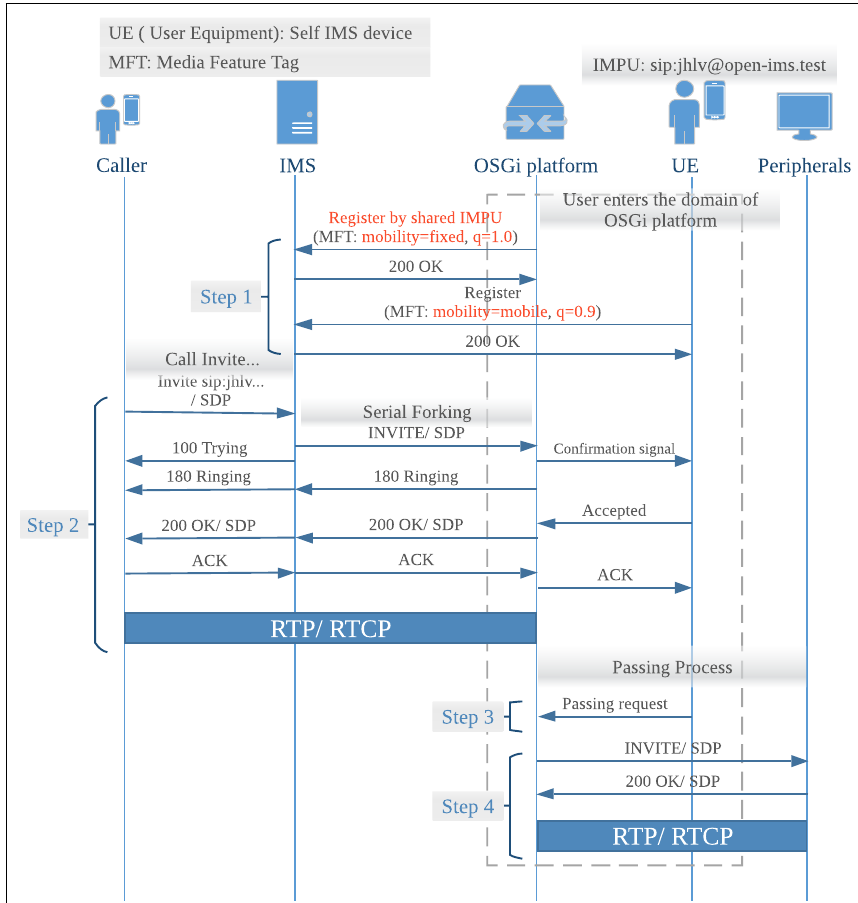
Figure 7. The session establishment procedure in the proxy mode.